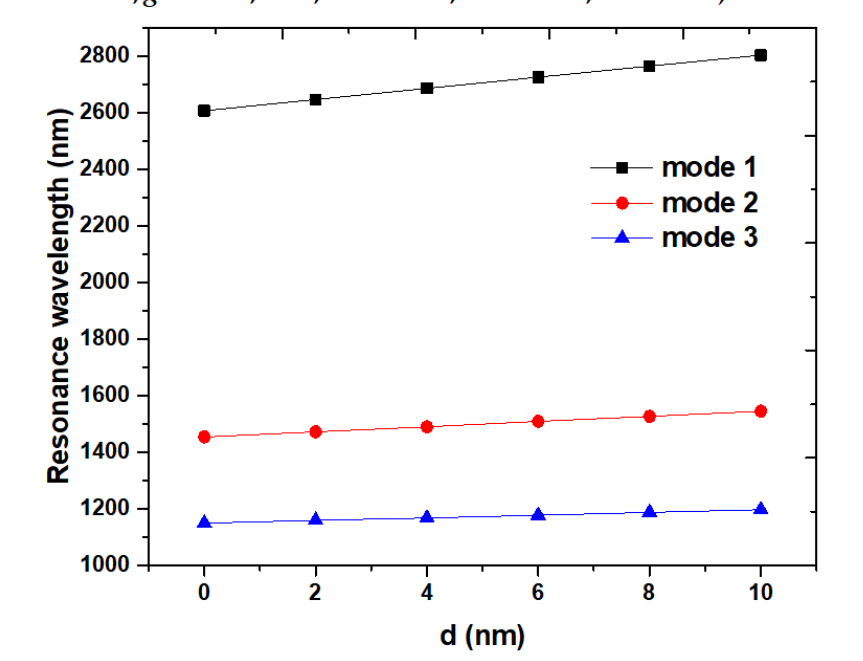
Figure 5. Resonance wavelength versus variation of d from 0 to 10 nm with an interval of 2 nm.